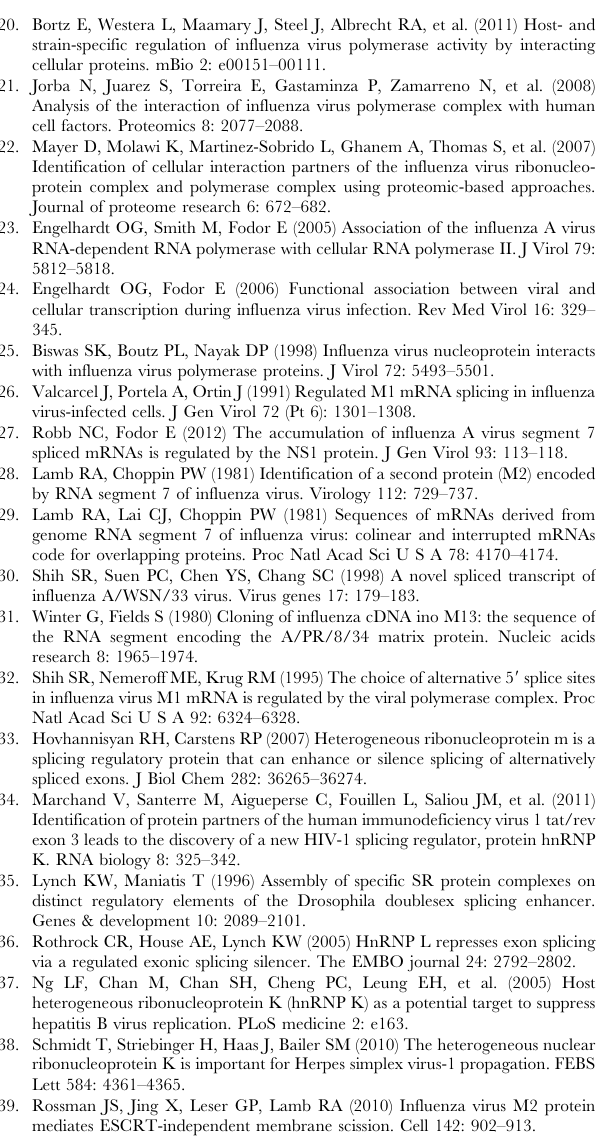
antibody to hnRNP K or an IgG control. Molecular weight markers and a total crosslink reaction are shown. Figure S3 hnRNPs A1, L, and M do not alter M2 expression. A549 cells were transfected with non-targeting or hnRNPA A1, L, and M siRNAs for 48 h prior to infection. siRNA transfected cells were infected with A/WSN/33 at MOI 2. Cells were harvested at the indicated hours post-infection, and viral protein accumulation was assessed by immunoblot analysis. Each protein band was quantified by ImageJ and normalized to a - tubulin levels. Figure S4 Detection of NS1-BP and hnRNP U in JSL1 nuclear extract. JSL1 nuclear extract was subjected to immunoblot analysis with antibodies specific to hnRNP U (A) and NS1-BP (B), detected using different amounts of extract. MW, molecular weight markers. (TIFF)